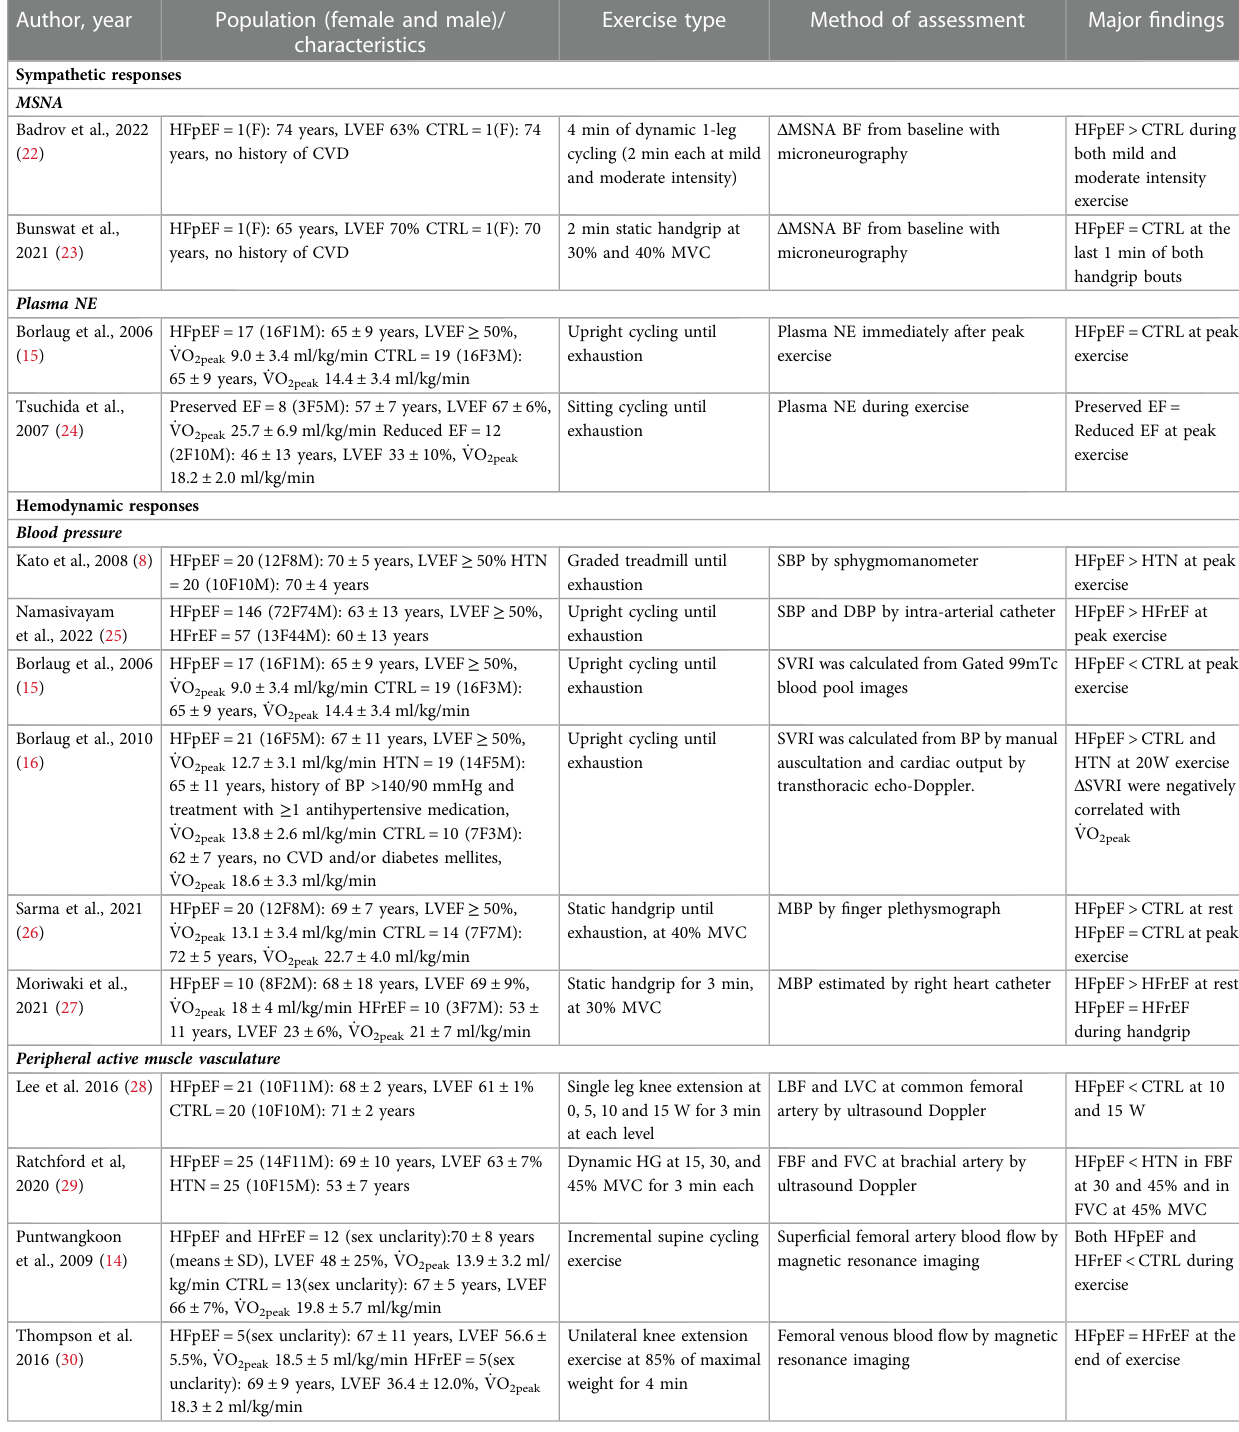
TABLE 1 Sympathetic and hemodynamic responses to dynamic and static exercise in HFpEF vs. HFrEF or